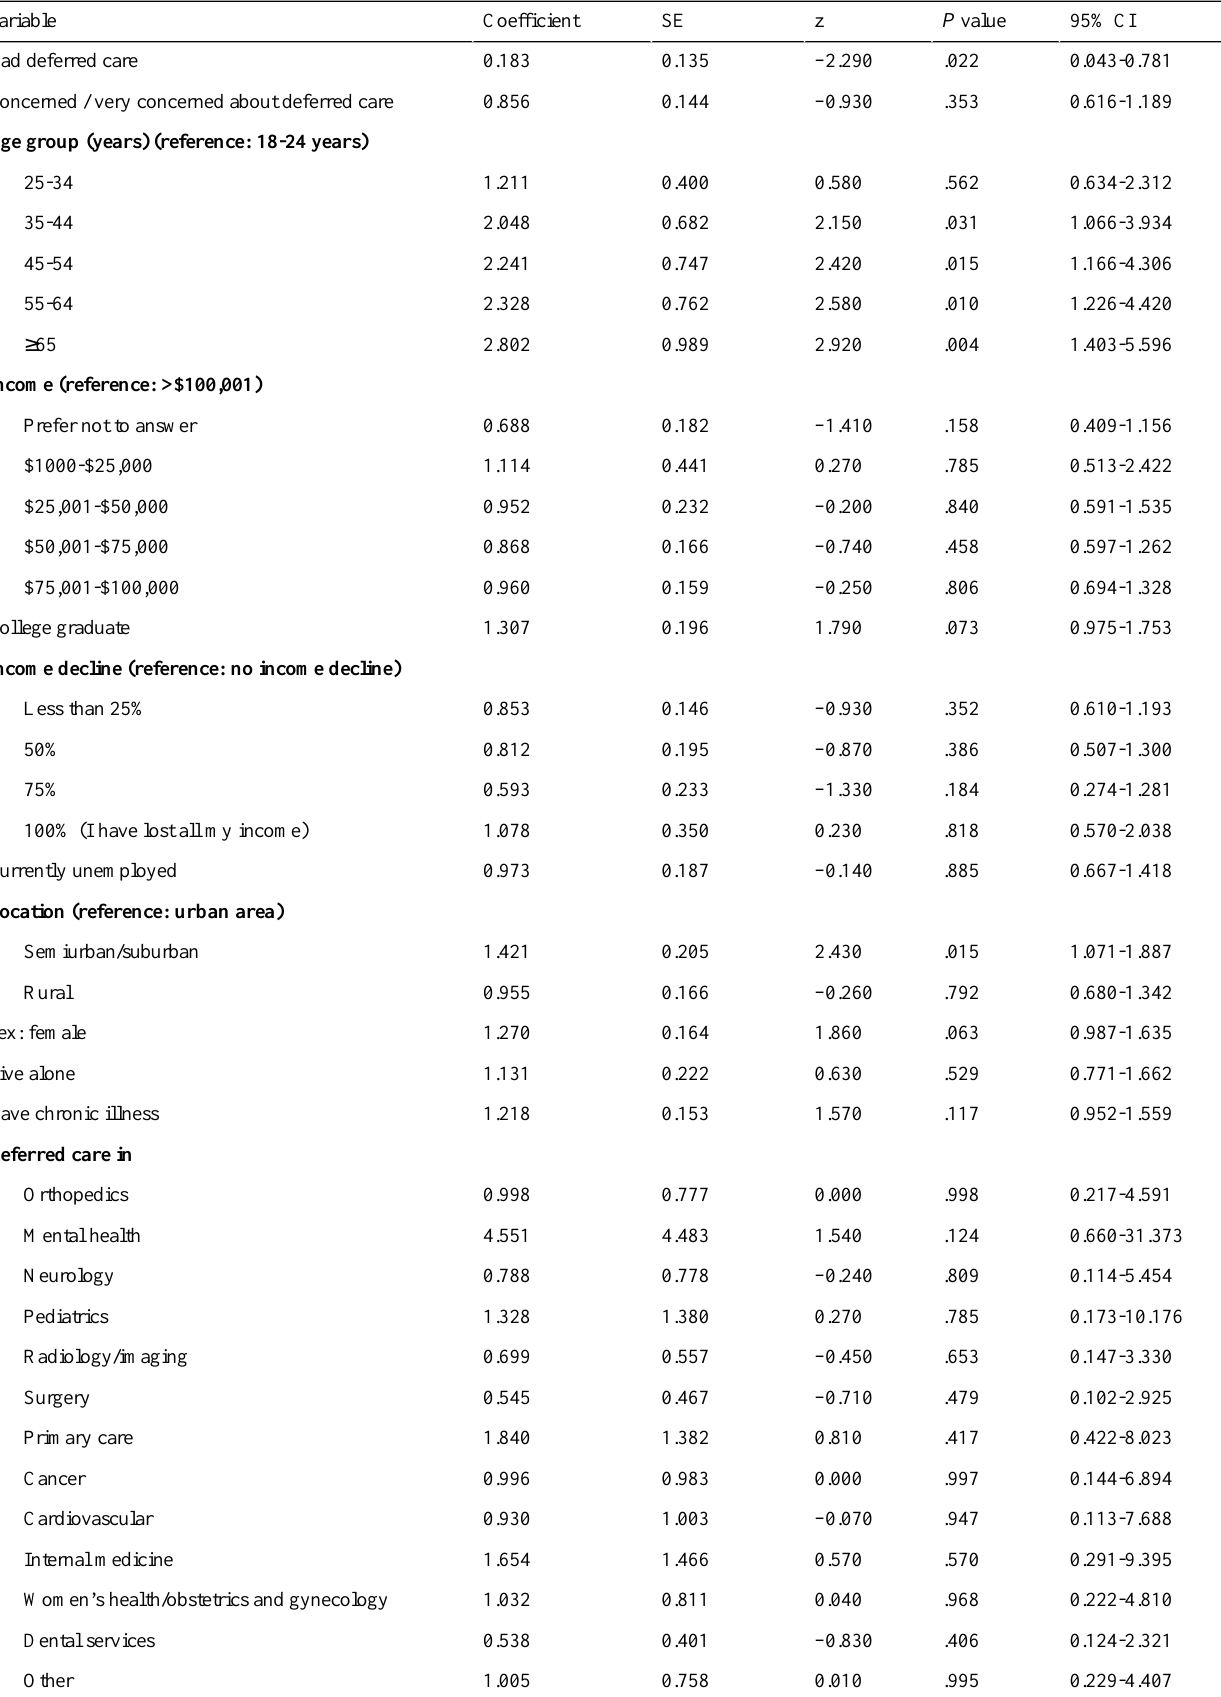
Table 7. Logit regression explaining factors predicting willingness to use telemedicine for deferred care among 1861 survey respondents in Vermont between April 30 and May 13, 2020 with coefficients representing percentage point